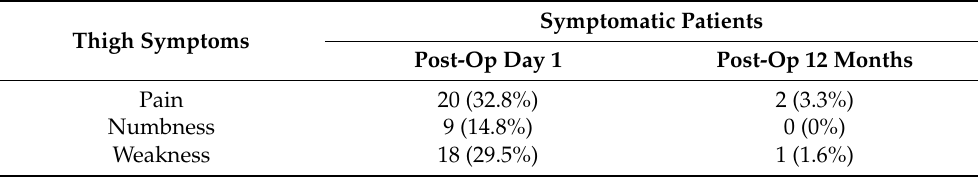
Table 3. Postoperative thigh symptoms in symptomatic group.